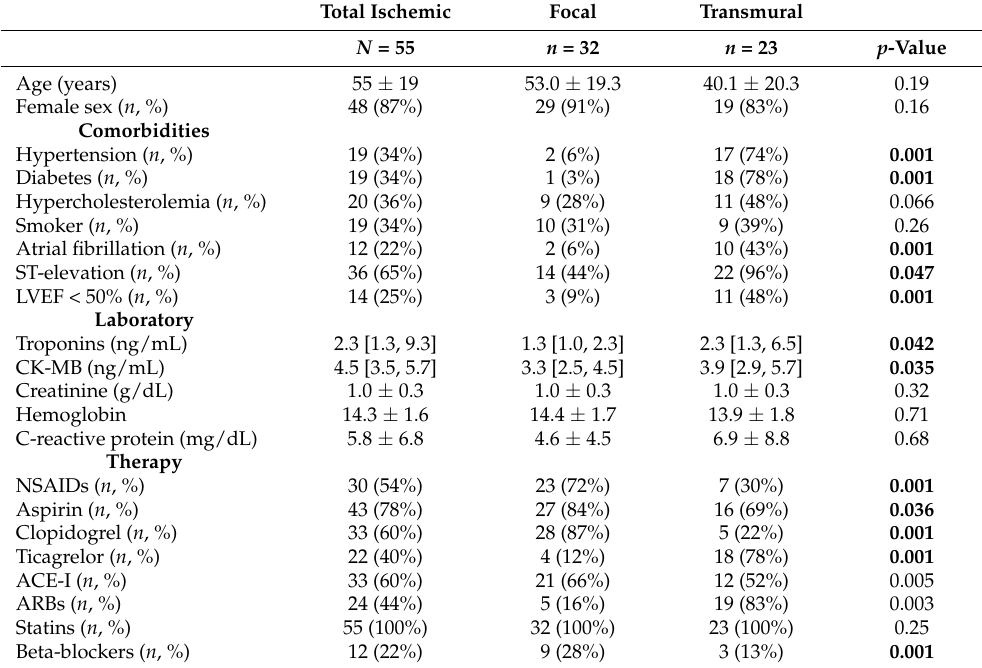
Table 2. General characteristics according to CMR ischemic patterns: focal and transmural. Total Ischemic Focal Transmural N = 55 n =